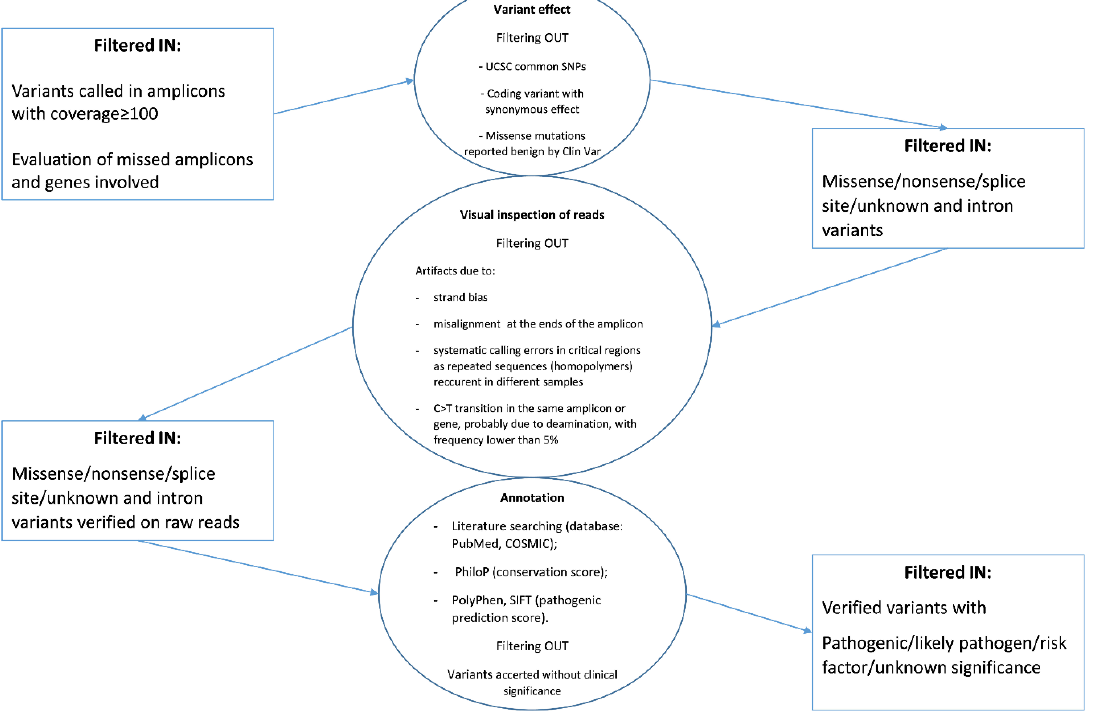
Figure 2. Flow chart of filter chain used for the prioritization of variants detected by NGS.